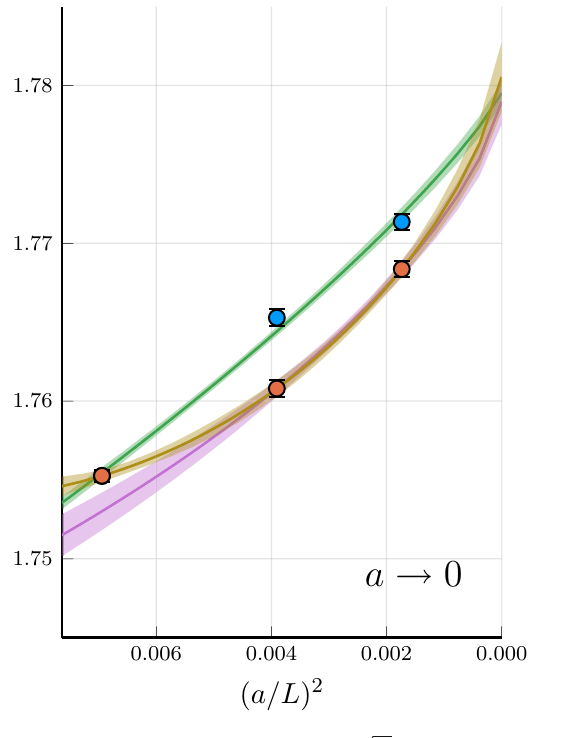
This gives a quantitative explanation to the fact that the sta- tistical uncertainties are large at large values of c